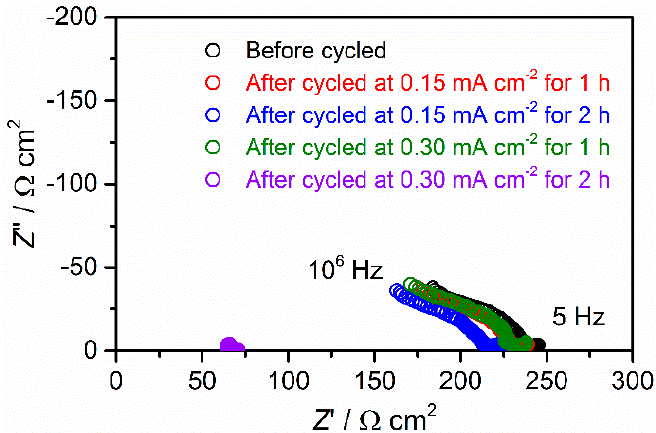
Figure 9. A/C impedance measured at 27 °C for Li/LLZT/Li cell before and after galvanostatic cycling with different conditions described in the caption of Figure 8.